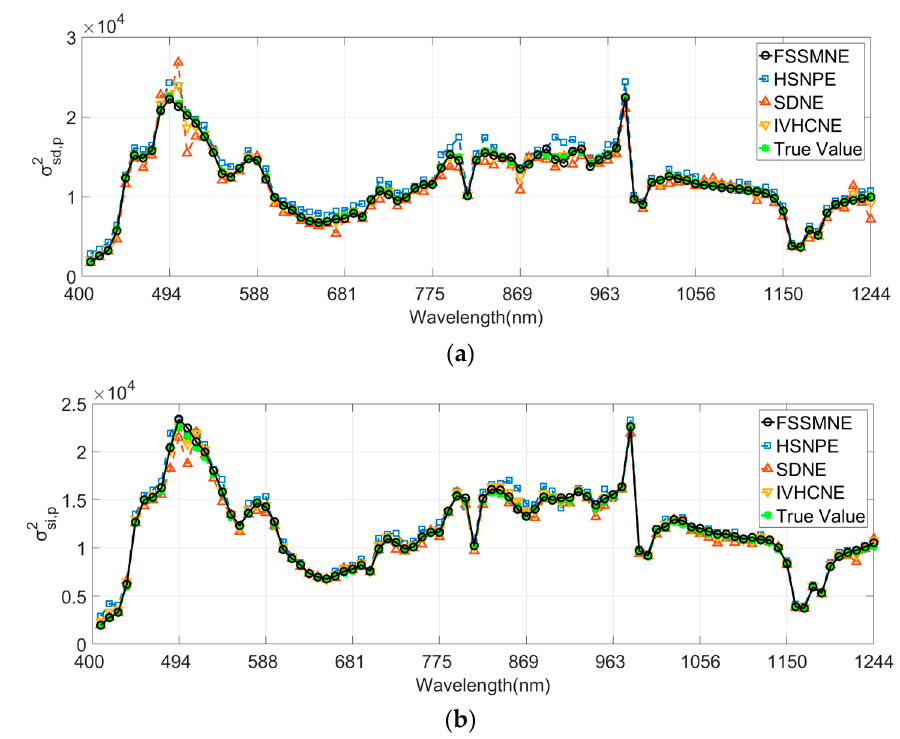
Figure 10. Noise estimates in each band of the synthetic HS image using the FSSMNE, HSNPE, SDNE, and IVHCNE methods. ( a ) Estimates of the SD noise variance; ( b ) estimates of the SI noise variance. FSSMNE, frequency superpixel segmentation-based mixed noise estimation; HSNPE, hyperspectral noise parameter estimation; SDNE, signal-dependent noise estimation; IVHCNE, intensity-variance homogeneity classification-based noise estimation.